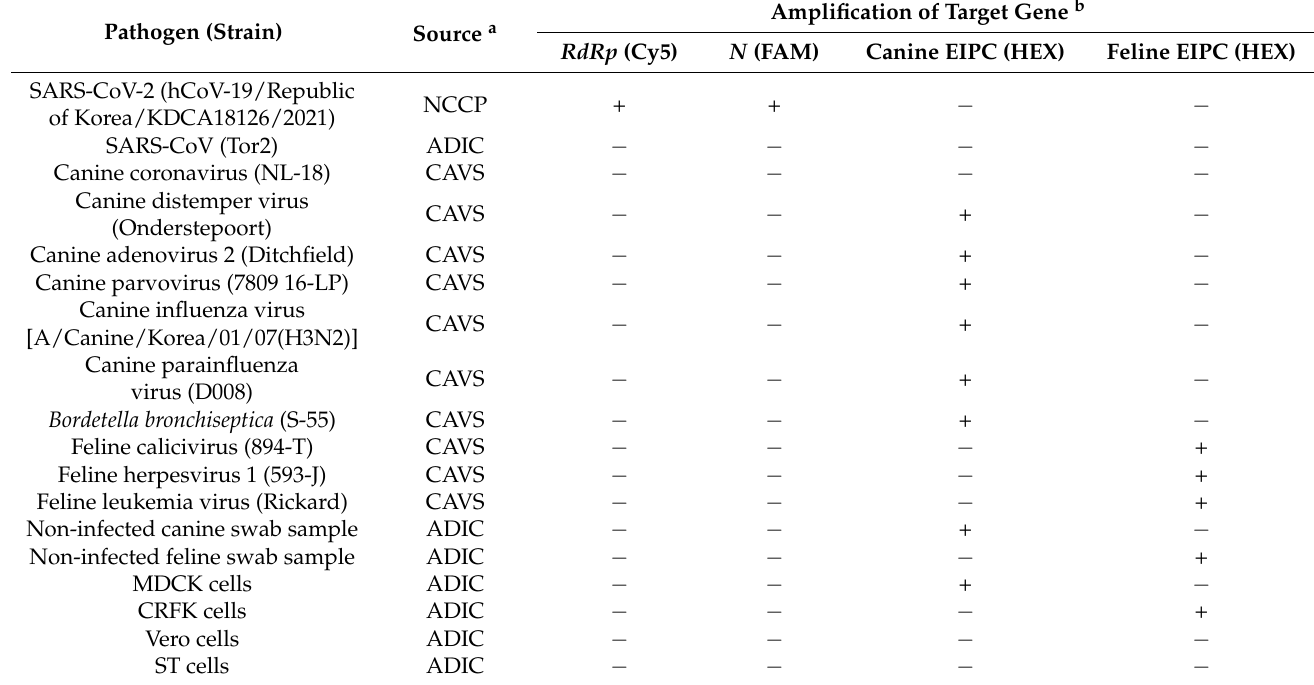
Table 2. Specificity of the mRT-qPCR assay using SARS-CoV-2 and EIPC-specific primer and probe